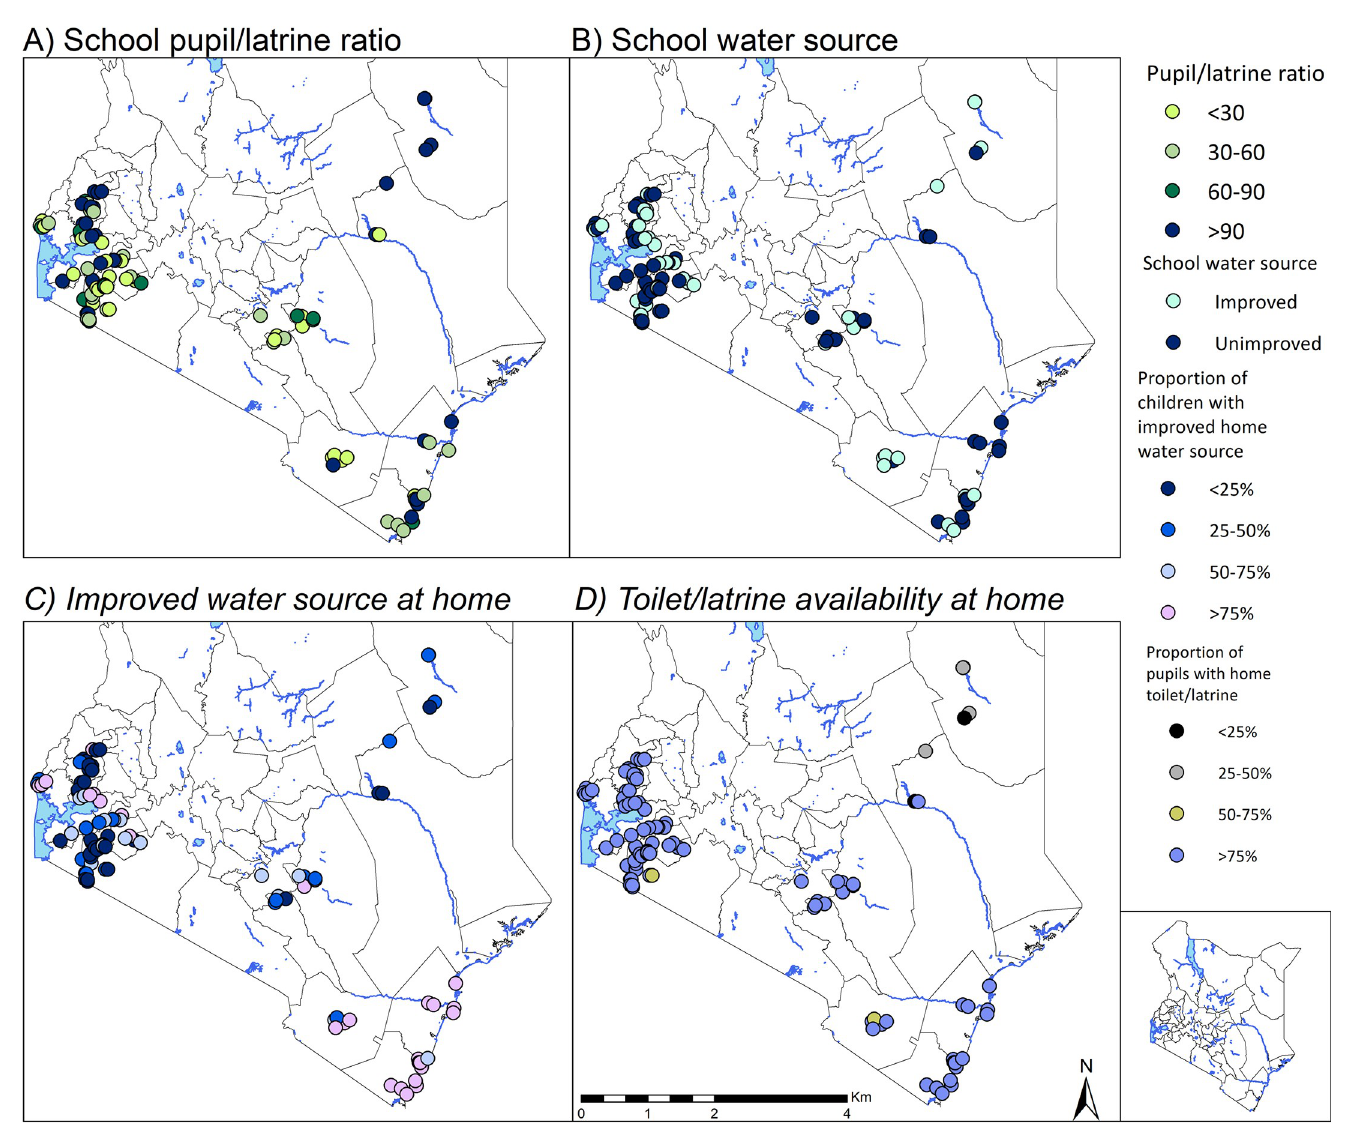
Fig 3. Distribution of school and household water and sanitation conditions in